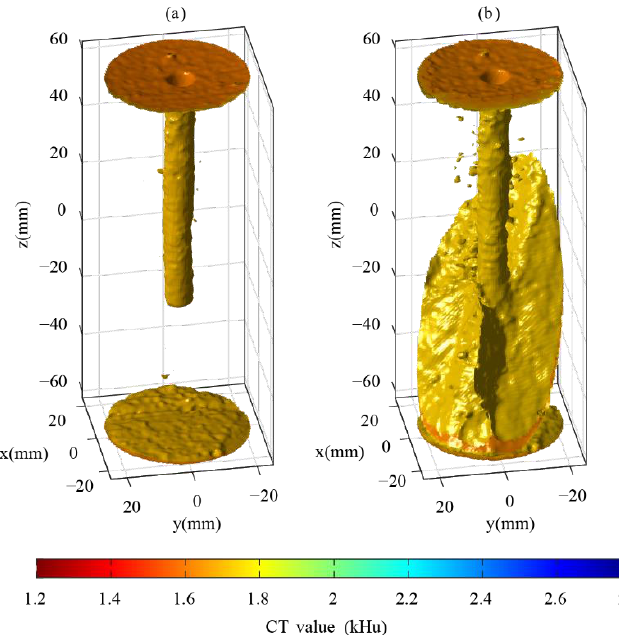
Figure 6. Three-dimensional borehole surface and hydraulic fracture surface extracted from the 3D CT scan images for the ( a ) intact and ( b ) fractured tight